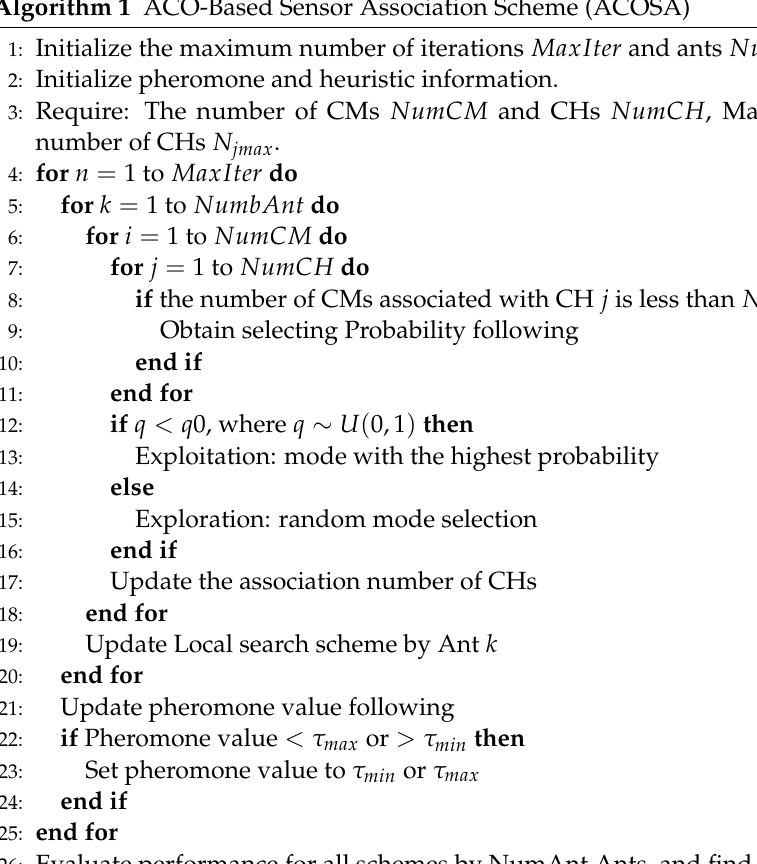
Algorithm 1 ACO-Based Sensor Association Scheme